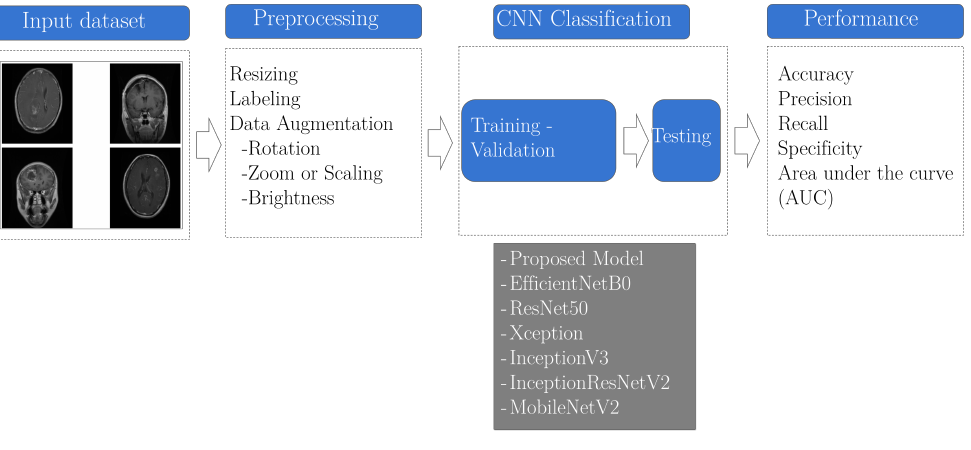
Figure 1. Flow diagram of the suggested method for BT